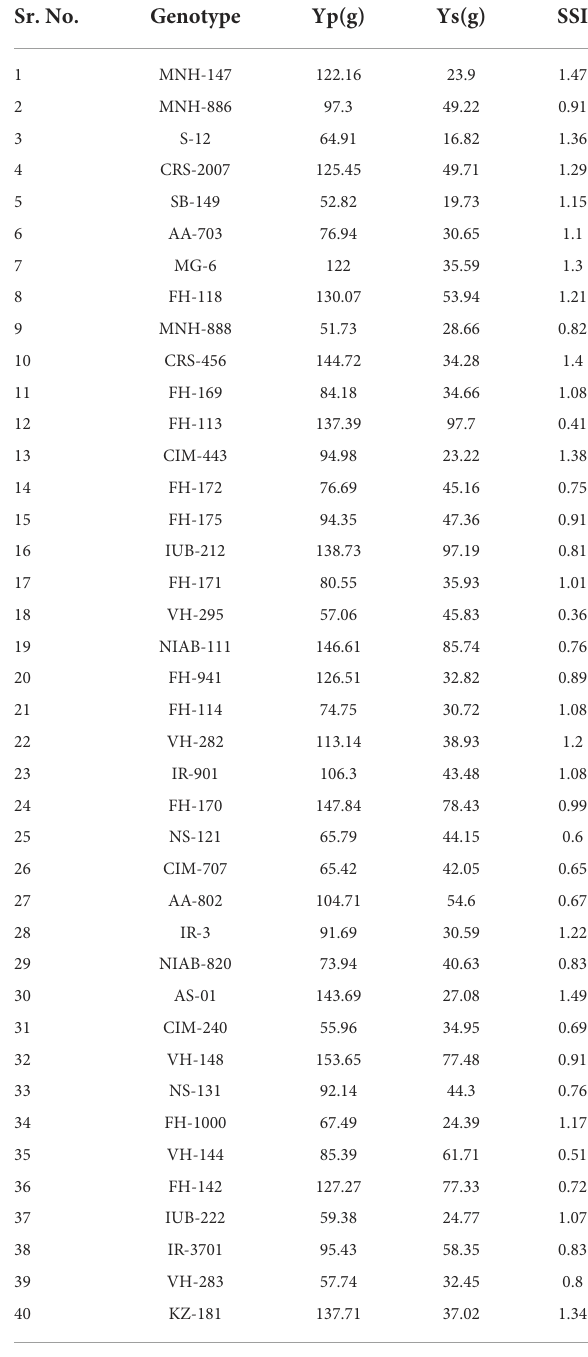
TABLE 1 Mean values of forty cotton genotypes for seed cotton yield under normal (Yp), seed cotton yield under water deficit (Ys), and stress susceptibility index